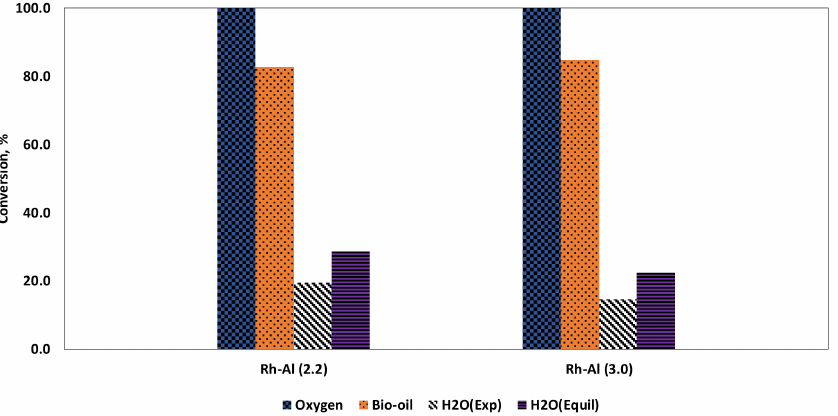
Figure 14. Conversion of oxygen, bio-oil, and water (experiment and equilibrium) using Rh-Al catalyst at 1 bar with reactor bed temperatures of 593 ◦ C ( λ = 0.318) and 572 ◦ C ( λ = 0.391) for S/C ratios of 2.2 and 3, respectively (S/C ratio in brackets next to catalyst